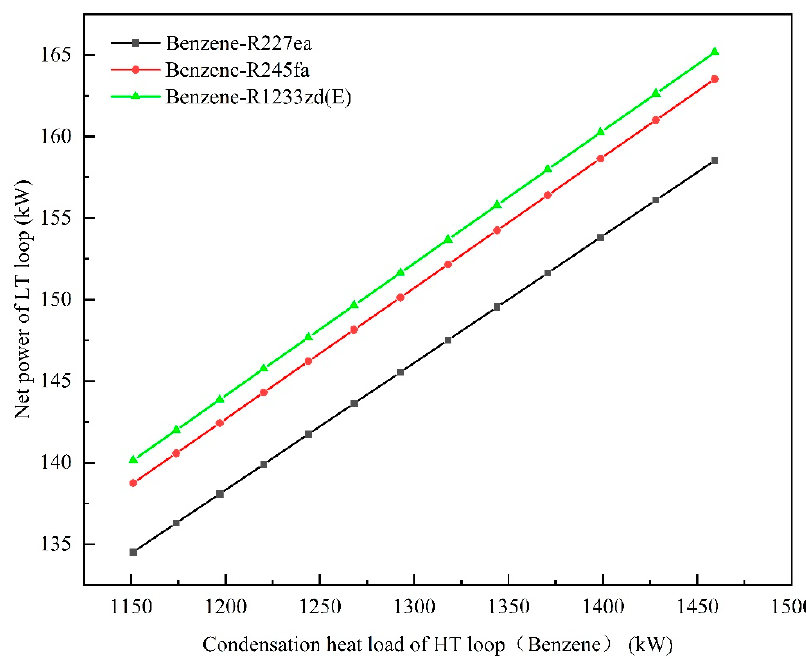
Figure 14. Net power of the LT loop with benzene as the HT loop’s working fluid.